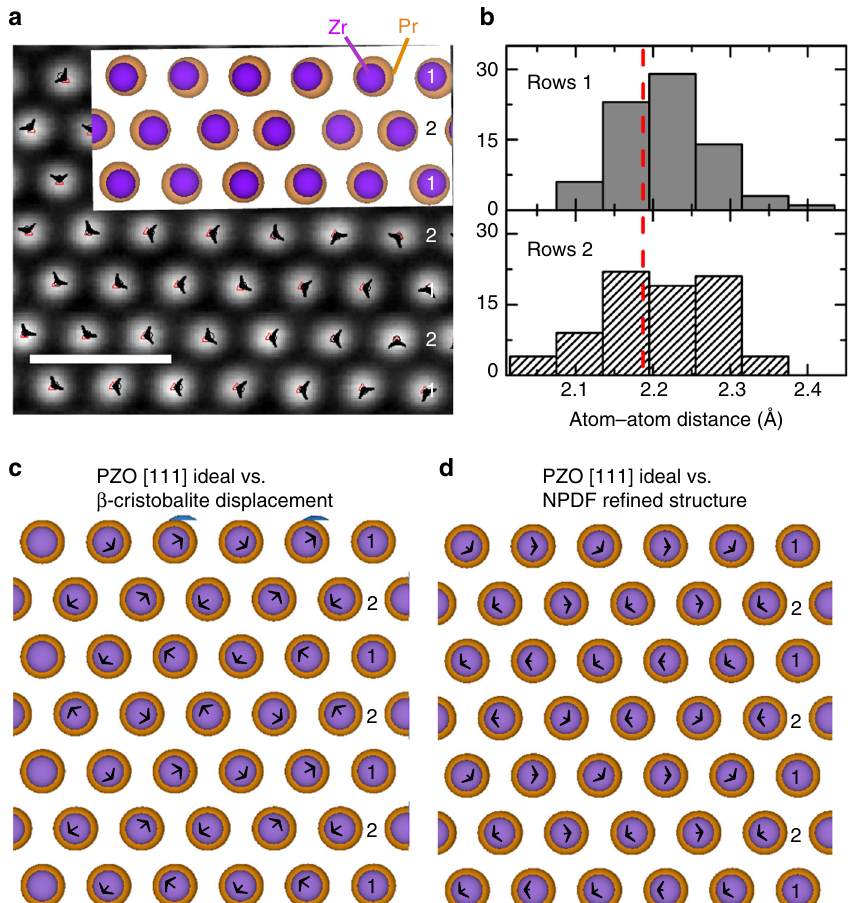
Fig. 6 Pr 2 Zr 2 O 7 HAADF STEM images and simulations. a HAADF STEM images of PZO in the [111] direction, with the P 4 3 2 1 2 structure from NPDF re fi nements overlaid. Back arrowheads represent a displacement vector from the ideal Fd (cid:1) 3 m structure (black circles) to experimental (red triangles) positions. Scale bar represents a distance of 0.50 nm. b Histogram of distance between spots in PZO [111] according to alternating rows 1 and 2, taken from multiple images. The red dashed line represents ideal distance between atomic columns from Fd (cid:1) 3 m Rietveld re fi nements. c Comparison of ideal Fd (cid:1) 3 m structure versus a P 4 3 2 1 2 structure with an exaggerated 0.03 nm Pr β -cristobalite displacement in the [111] direction. Black arrows demonstrate displacement vectors. d Comparison of ideal Fd (cid:1) 3 m structure versus a 0.013(2) nm Pr displacement from the NPDF re fi ned P 4 3 2 1 2 structure in the [111] direction. Displaced Pr cations shown in blue. Pr are shown in orange and Zr in purple, with Zr cations reduced by 20% for clarity